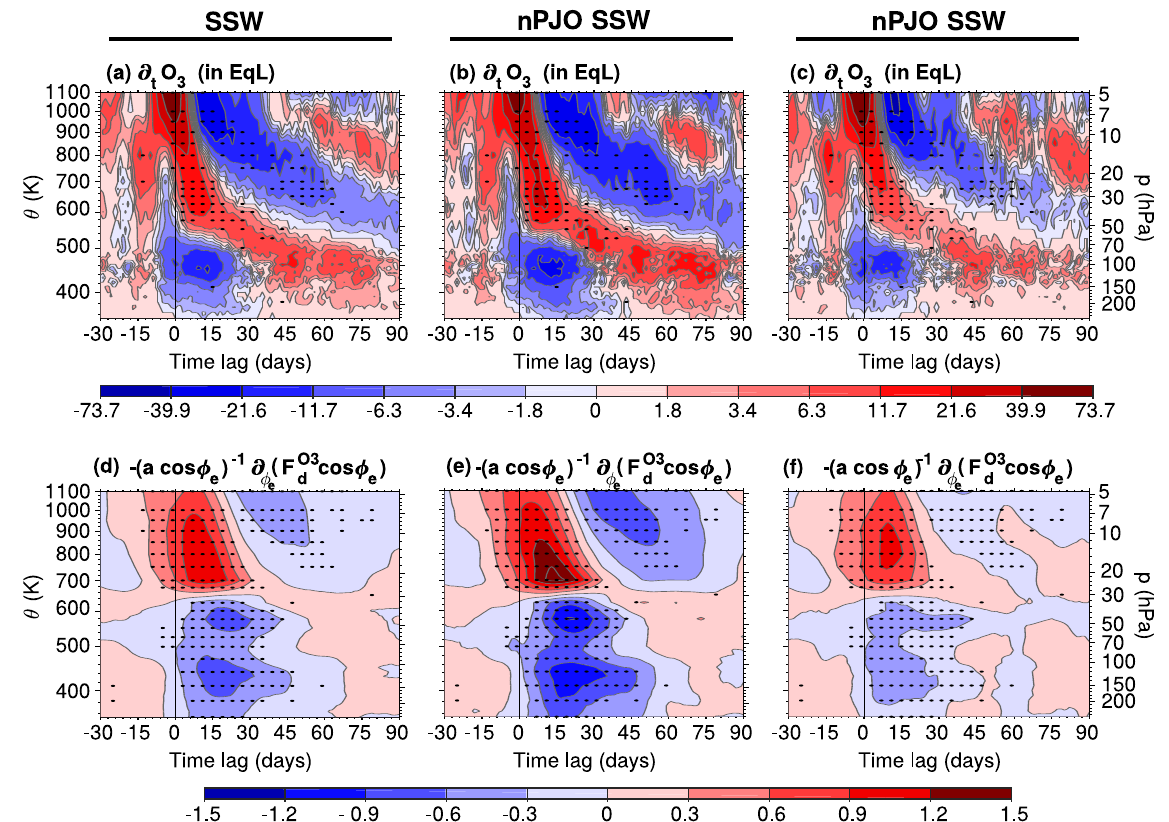
Figure 5. Composite evolution, centered on the SSW central date and averaged over equivalent latitudes φ e = 70–90 ◦ N, of (a, b, c) anomalies of ozone tendencies (ppbvd − 1 ), and (a, b, c) the standardized anomalies of mixing-induced ozone tendencies (see Eq. 3). (a, d) All SSW events in WACCM, (b, e) PJO SSW events, and (c, f) nPJO SSW events. Black dots indicate statistically significant values (two-tailed Student’s t test, α = 0 .